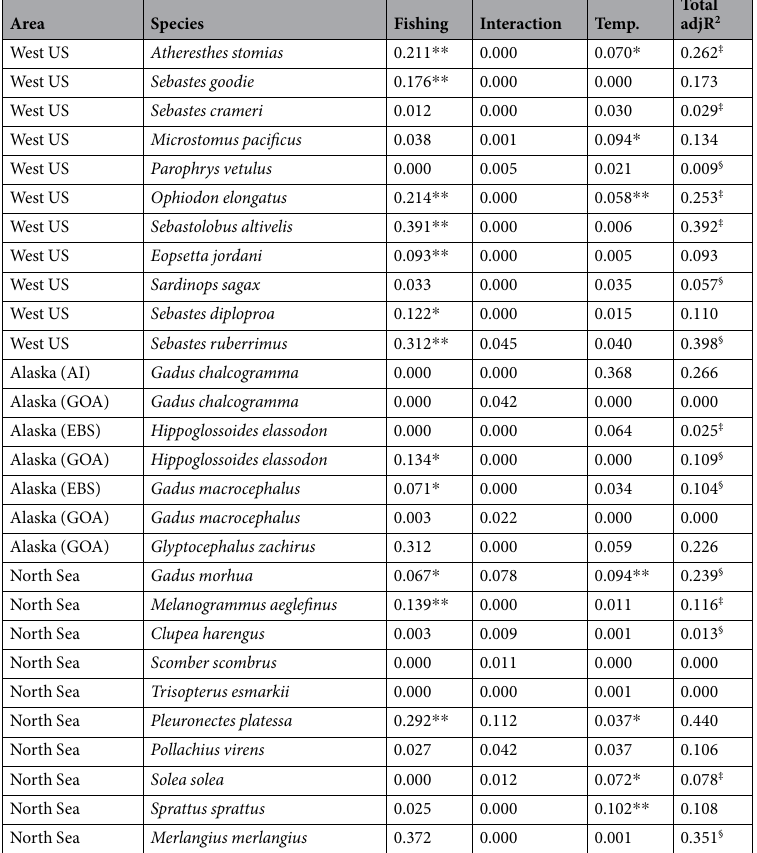
Table 2. Results of variation partitioning showing the relative contribution of fishing, temperature, and their interactive effect to the total variation (in term of adjusted R 2 value) for each of the 28 stocks. * Indicates P < 0.05; ** Indicates P < 0.01; § Indicates maximum adjusted R 2 at 1-year lag; ‡ Indicates maximum adjusted R 2 at 3-year lag.